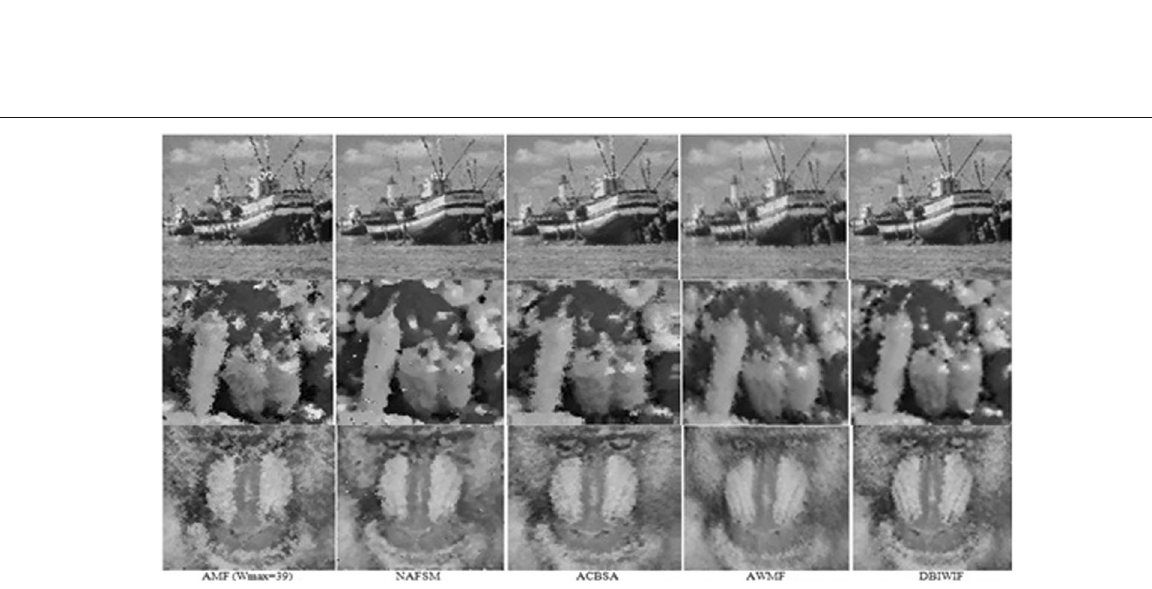
Fig. 12 Qualitative performance of various weighted algorithms corrupted by 90% salt and pepper noise on Boat, Pepper, Baboon Image